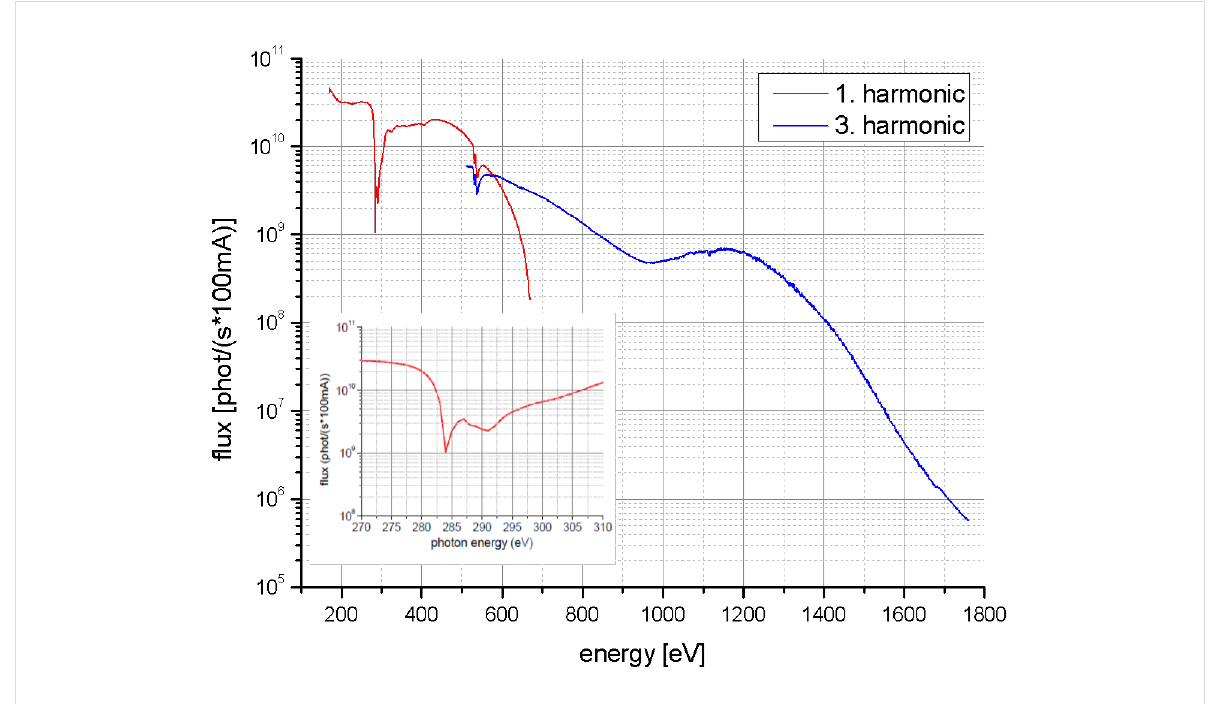
Figure 6: Measured integrated photon flux at the sample position of the HZB-TXM using a 10 µm exit slit of the monochromator for the 1. and 3. harmonic of the undulator. The inset shows the situation at the carbon-K-edge: A decrease of the flux due to the carbon contamination of the optical elements and the effect of the second order radiation (double photon energy, without using any